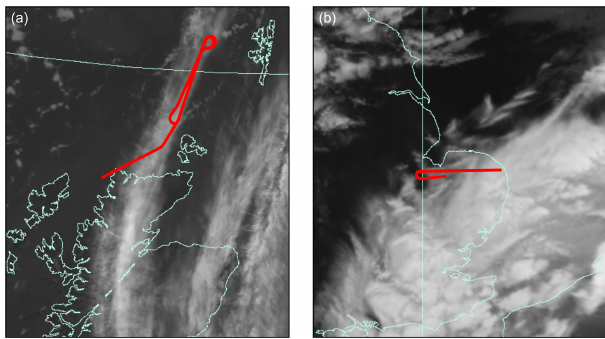
Figure 1. The 10.8µm infrared satellite image from the 10:02UTC MetOp-B overpass on 13 March 2015 (a) and 11:01UTC MetOp- A overpass on 9 February 2016 (b) . The aircraft track during the remote-sensing runs is overlaid in